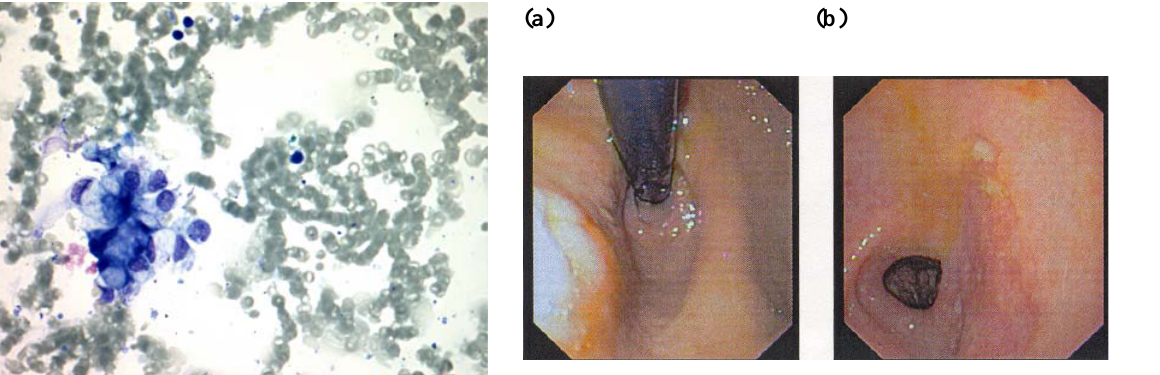
FIGURE 4. Upper gastrointestinal endoscopy demonstrating (a) a hiatal hernia unrelated to the leg’s edema and (b) the antrum mucosal infiltration and ulceration in the stomach from which biopsies were taken (see Fig. 5).